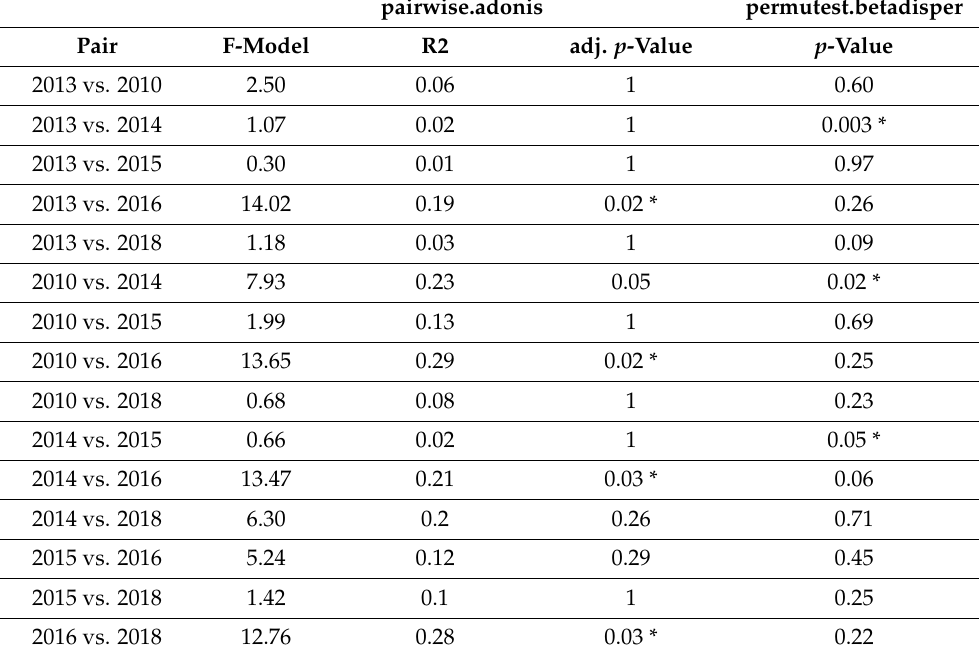
Table 2. Pairwise permutational analysis of variance (PERMANOVA, pairwise.adonis) to compare the meiofauna community observed in different years, p -value adjusted according to the Bonferroni correction, and significance of pairwise comparison of group dispersion (permutest.betadisper) (* indicating significance). pairwise.adonis